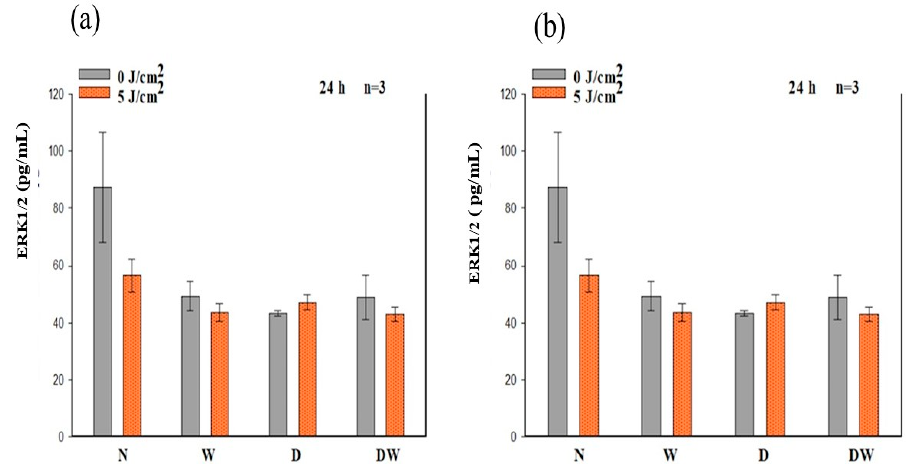
Figure 9. Phosphorylated (p-) ERK1/2 (MAPK) following irradiation at 660 nm and a fluence of 5 J/cm 2 , as determined by ELISA in non-irradiated and irradiated normal (N), wounded (W), diabetic (D), and diabetic wounded (DW) cell models at 24 h ( a ) and 48 h ( b ). Data are expressed as ± SEM (n = 3).